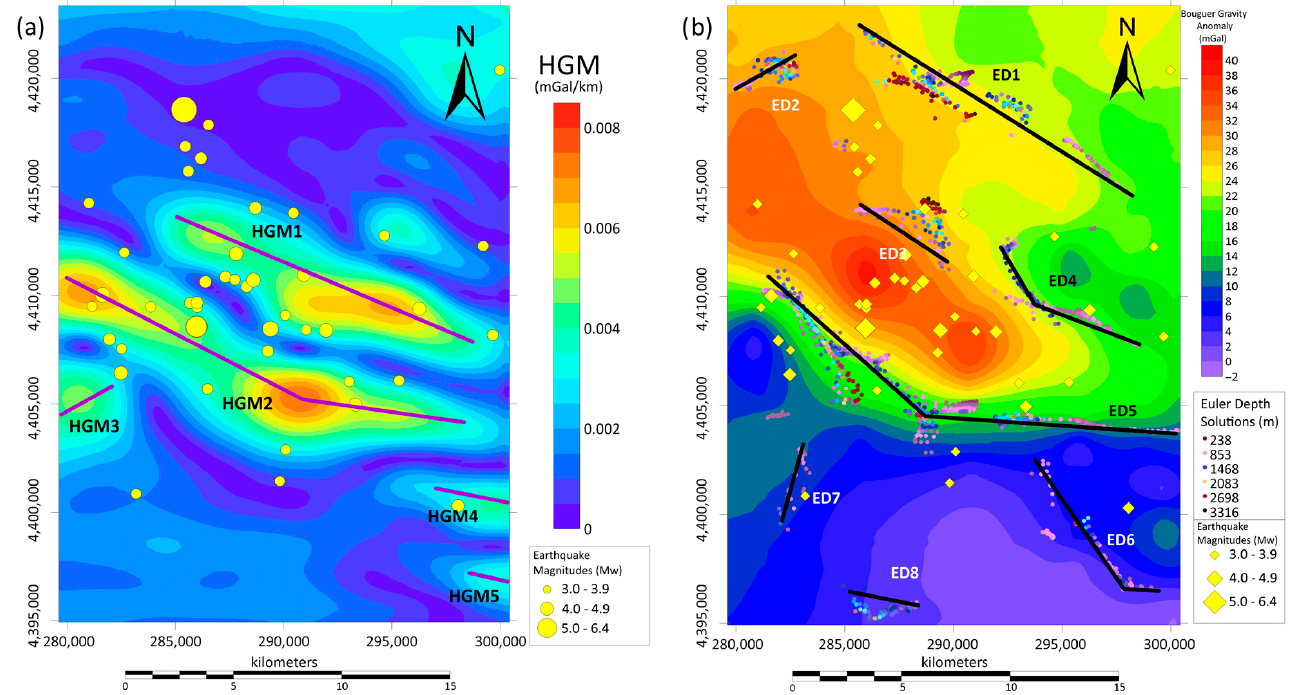
Figure 7. ( a ) The HGM map and Mw 3.0 and above earthquake locations in the study area. ( b ) The Euler Deconvolution results and Mw 3.0 and above earthquake locations in the study area (datum: WGS84 UTM Zone 36 N).